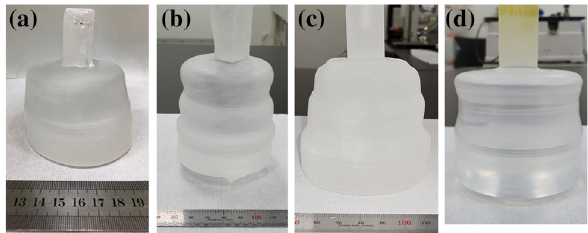
Fig. 3 Four NaI(Tl) crystal ingots produced by the small grower : a NaI-025, b NaI-034, c NaI-035, and d NaI-036